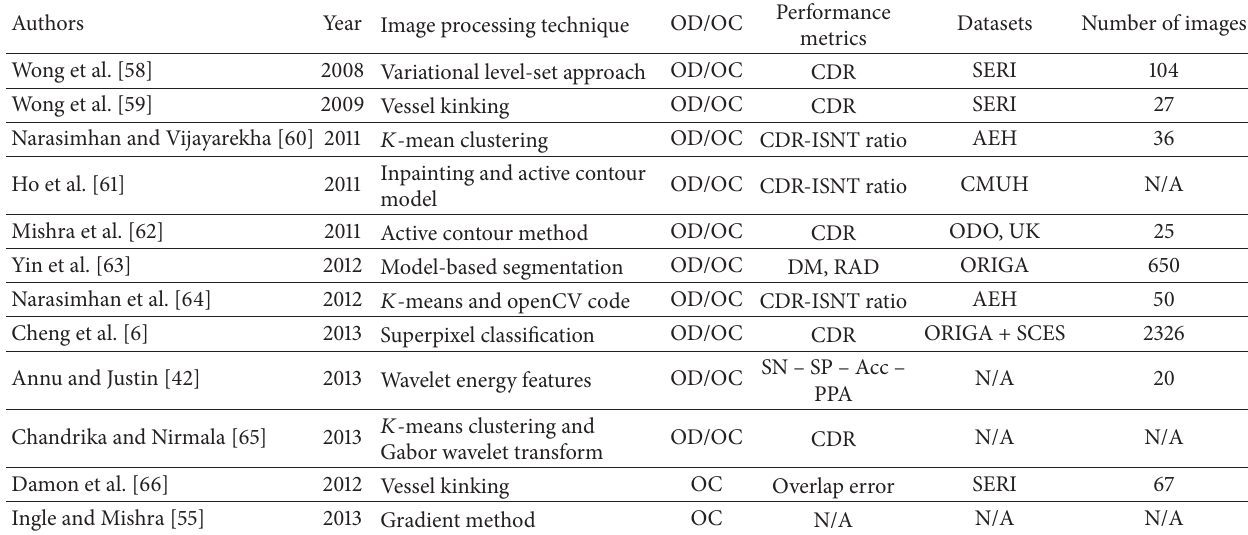
Table 4: Categorization optic disc with optic cup segmentation methods.